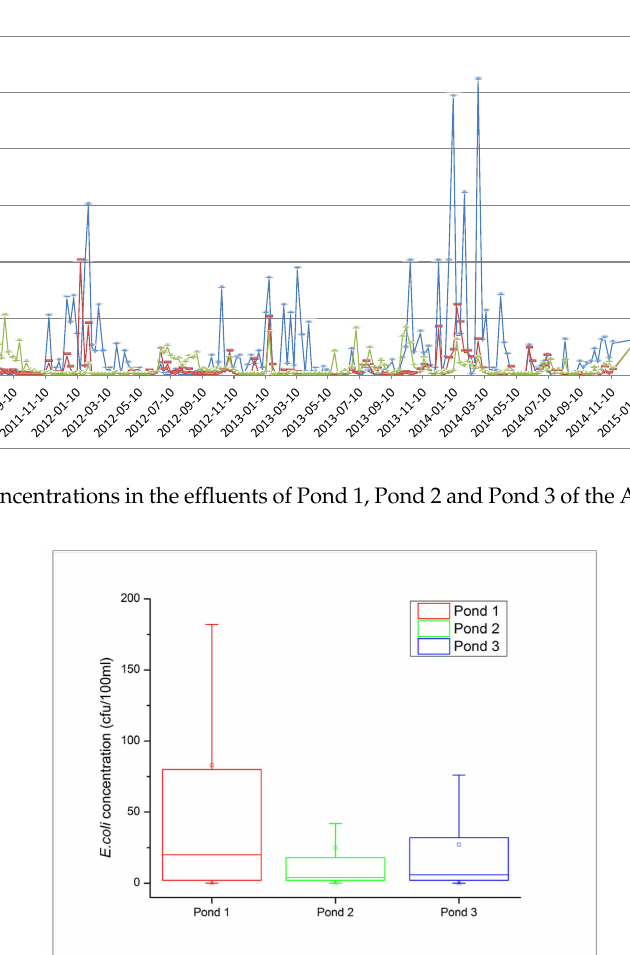
Figure 3. Average, median, minimum and maximum value of E. coli concentrations in the WSP effluents over a four year monitoring period.